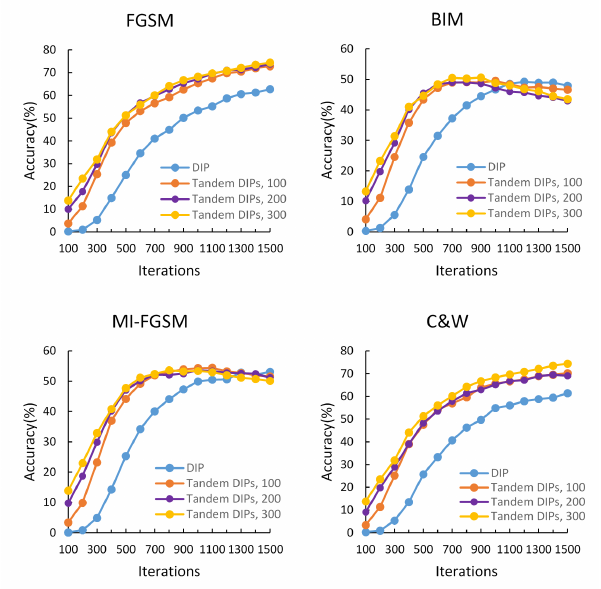
Figure 6. The classification accuracy of Inception-v3 on adversarial images generated by four attacks. The blue line represents the accuracy of Inception-v3 with DIP for defense.